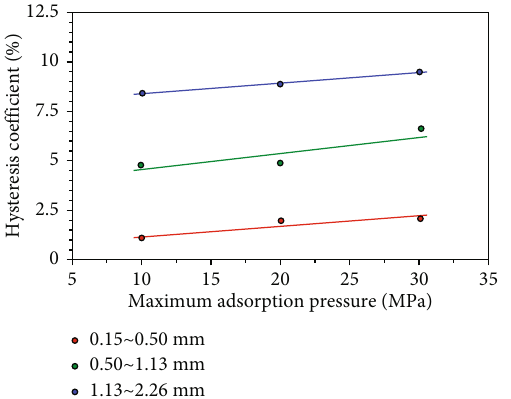
Figure 5: Degree of hysteresis and relationship between maximum adsorption pressure and coal particle